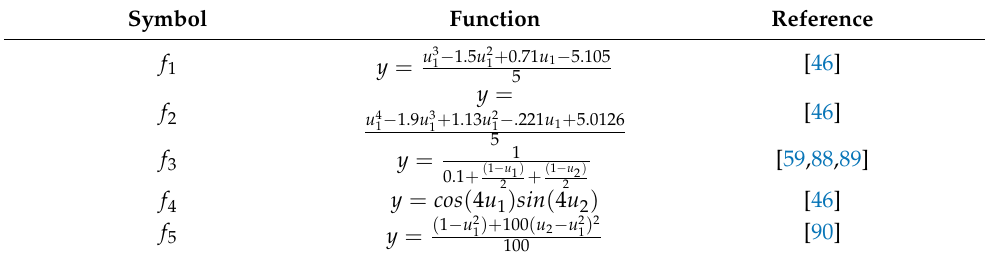
Table 1. Performance evaluation